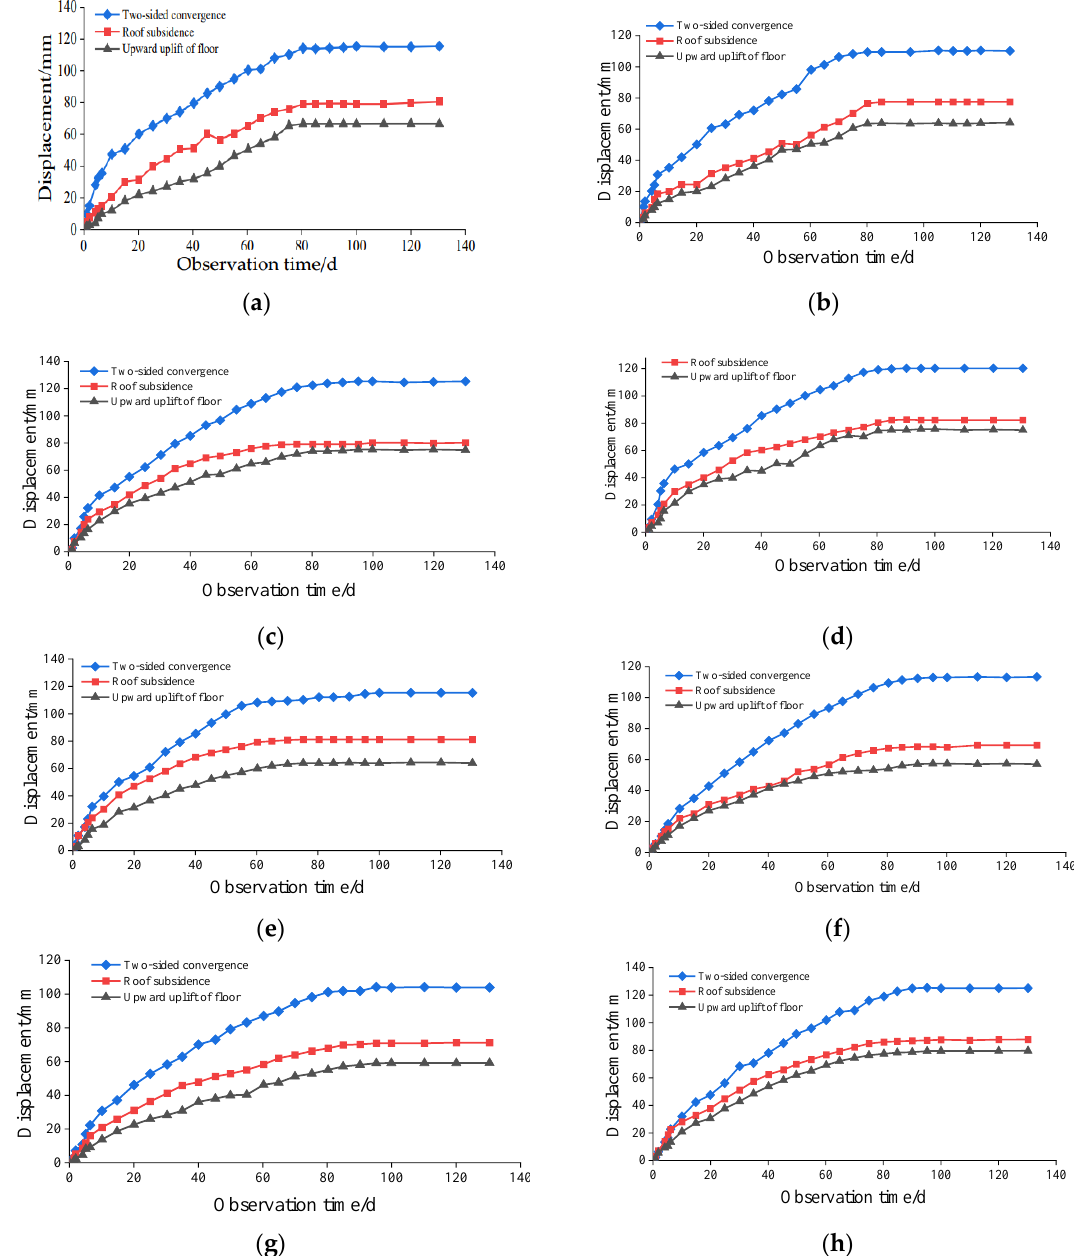
Figure 17. Surrounding rock deformation curve. ( a ) 1#; ( b ) 2#; ( c ) 3#; ( d ) 4#; ( e ) 5#; ( f ) 6#; ( g ) 7#; and ( h ) 8#.